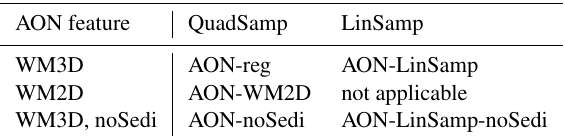
Table 2. Summary of AON